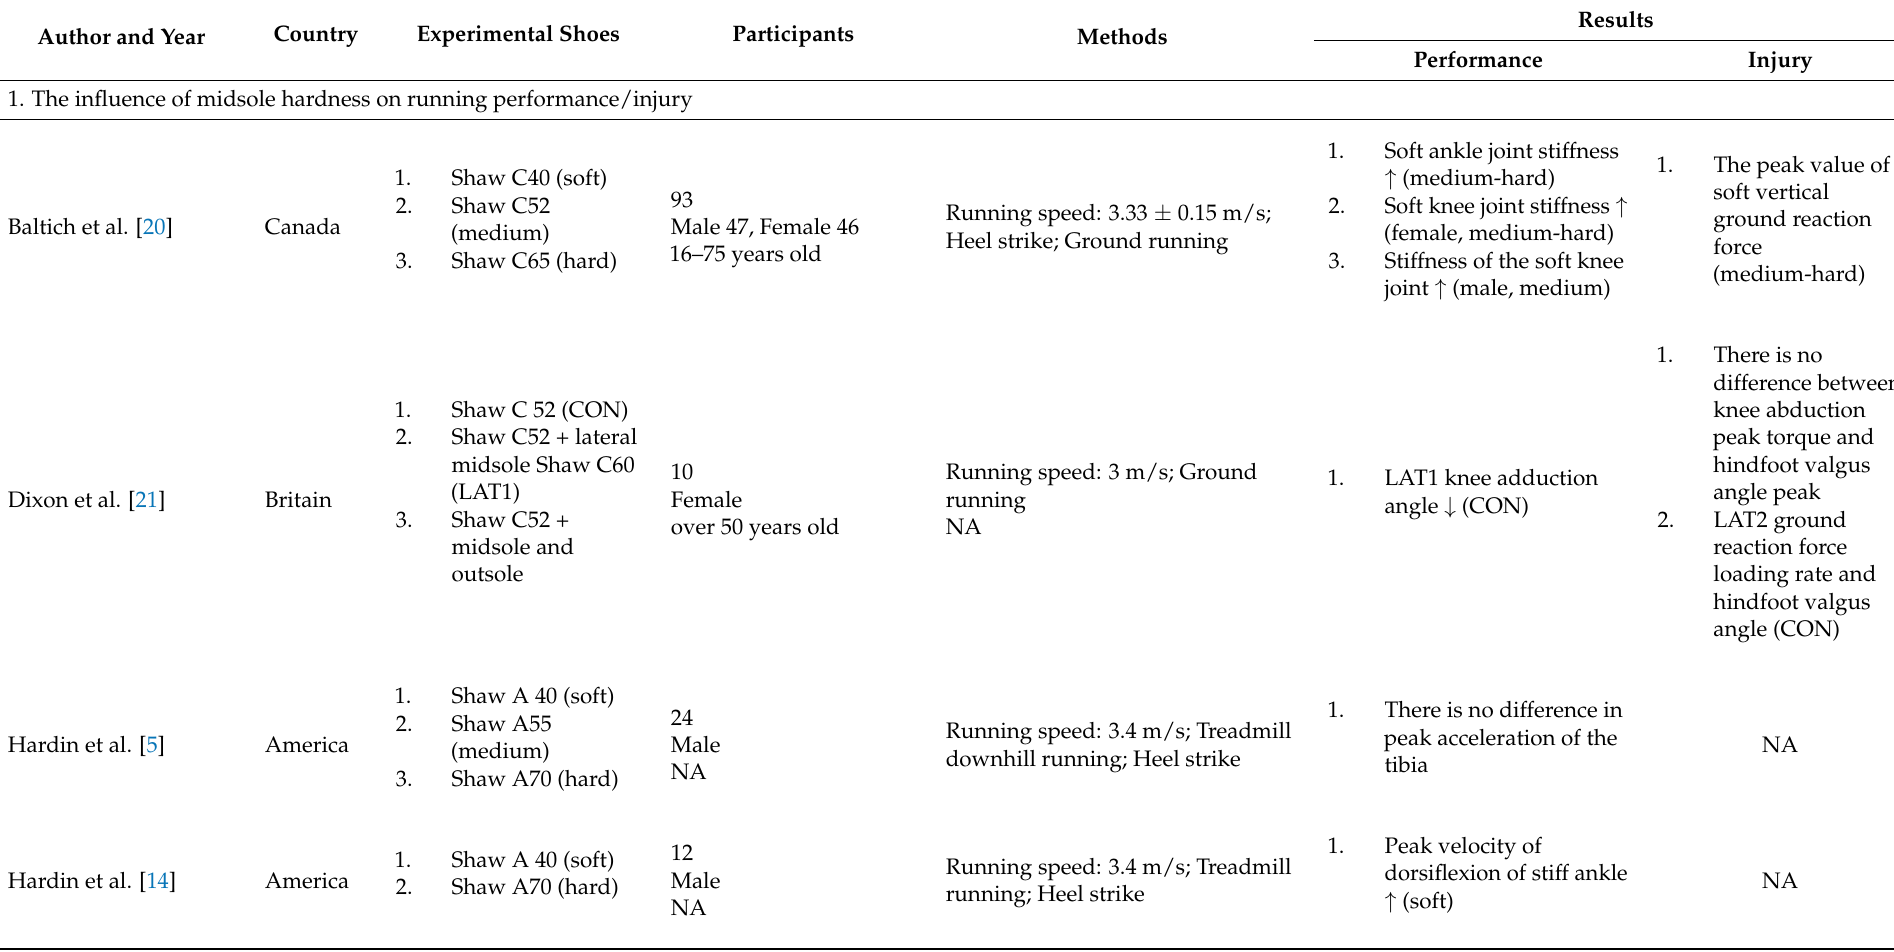
Table 1. The influence of running shoes’ midsole on running performance and related